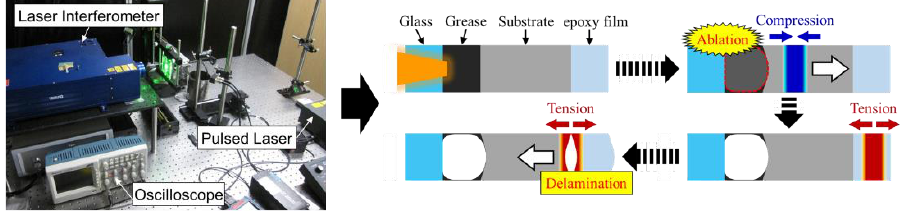
Fig.2 Experimental setup and overview of